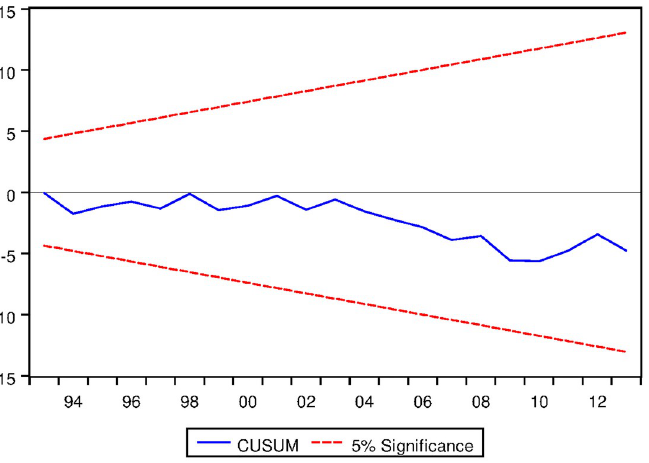
Fig 17. Stability diagnostic of cointegrating relationship for Australian data with no fixed regressor under proposed framework.